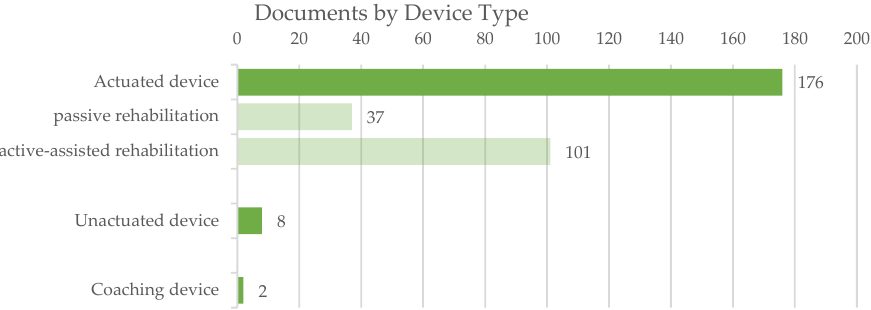
Figure 11. The distribution of exoskeletons by device type. The majority of the scientific work concerns actuated exoskeletons, and active rehabilitation is the most